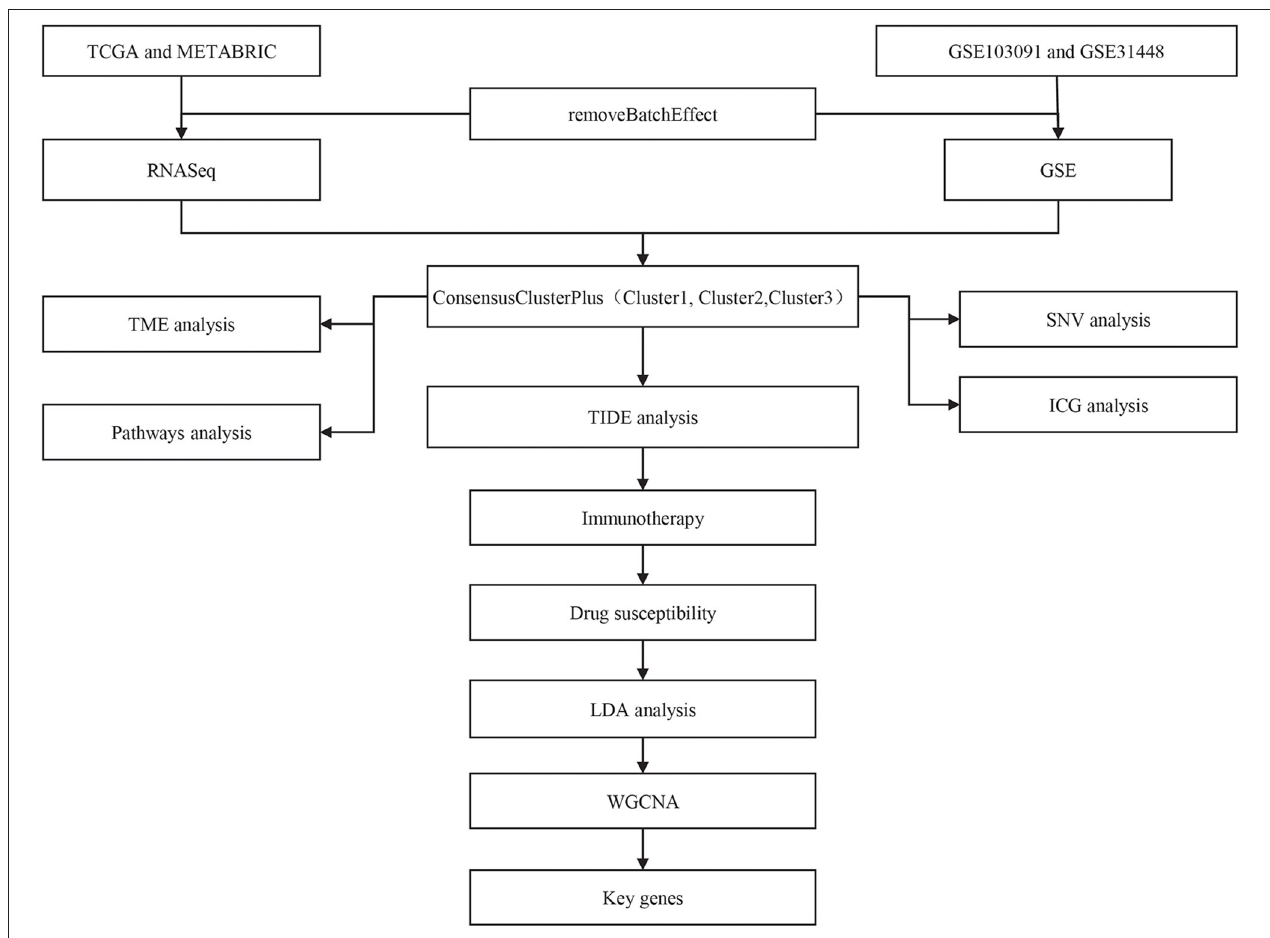
FIGURE 1 | The workflow chart of this